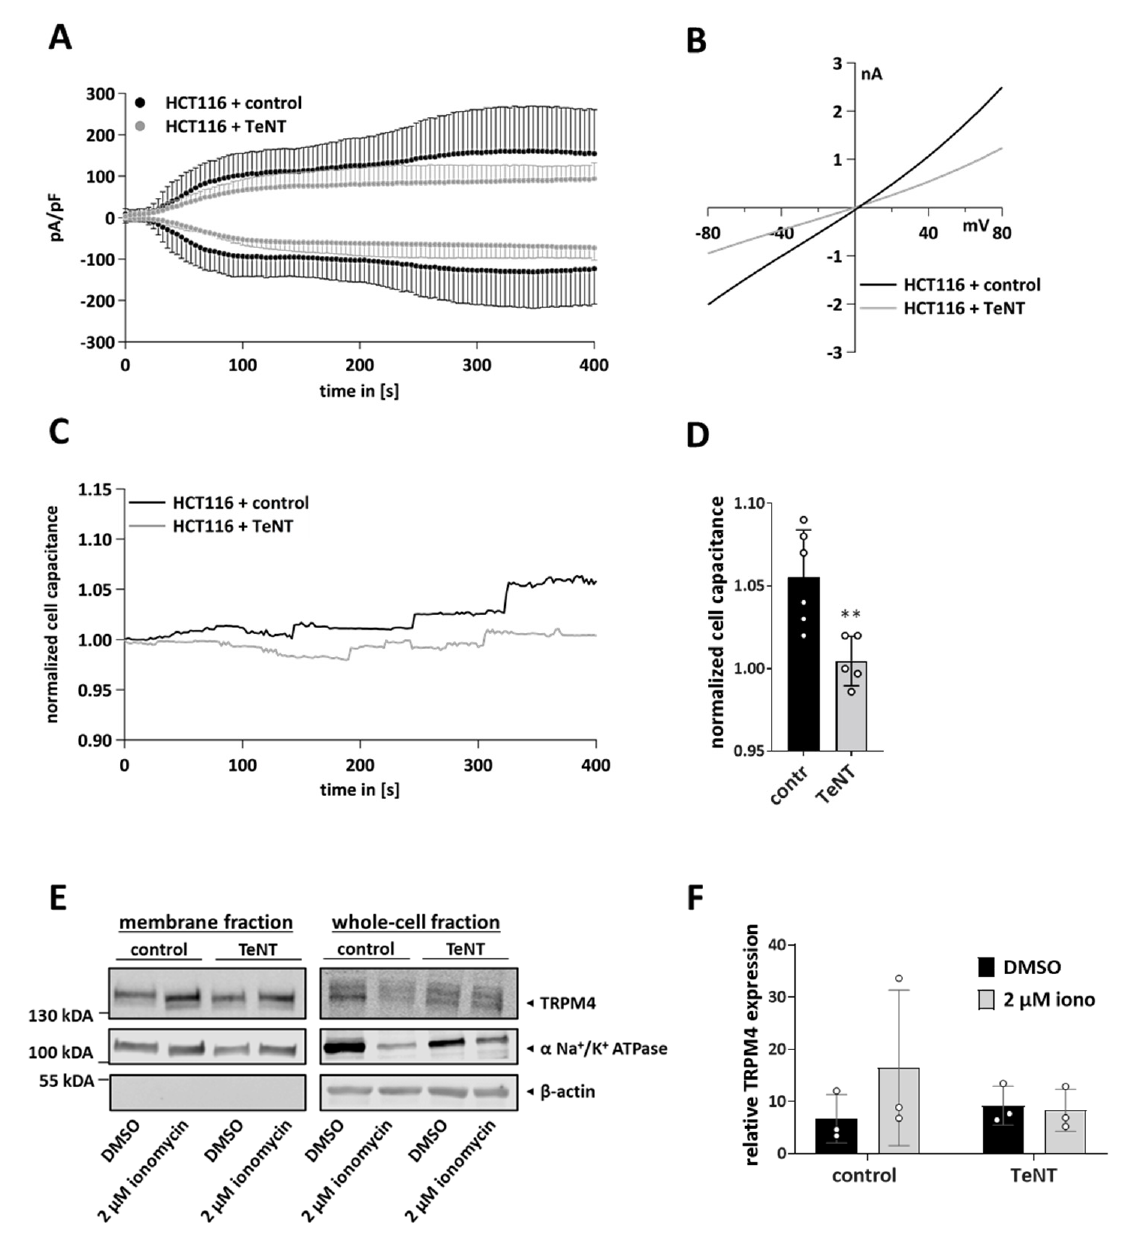
Figure 5. Overexpression of tetanus toxin in HCT116 cells. HCT116 cells were transfected with tet- anus toxin light chain (TeNT) or the control vector. ( A ) Whole-cell patch clamp recordings were performed 48 h post-transfection. I CAN was evoked with 10 μ M Ca 2+ in the pipette ( n = 6 for HCT116 + control, n = 7 for HCT116 + TeNT). ( B ) Corresponding IVs at 394 s from cells in A. ( C ) Normalized cell capacitance plotted versus time for cells in A. ( D ) Bar diagram of data (mean + SEM) at 394 s from ( C ). Statistical analysis was performed with unpaired t -test (** p < 0.01). ( E ) Biotinylation assay was performed 48 h after transfection. Cells were stimulated with 2 μ M ionomycin or DMSO for 15 min, and TRPM4 membrane expression was analyzed with a biotinylation assay (plasma membrane and whole-cell expression of TRPM4). DMSO was used as a control. α -Na + /K + -ATPase was used as a loading control for the membrane fraction and β -actin as a loading control for whole-cell TRPM4 fraction. ( F ) Quantification of TRPM4 plasma membrane expression levels, shown as mean + SEM